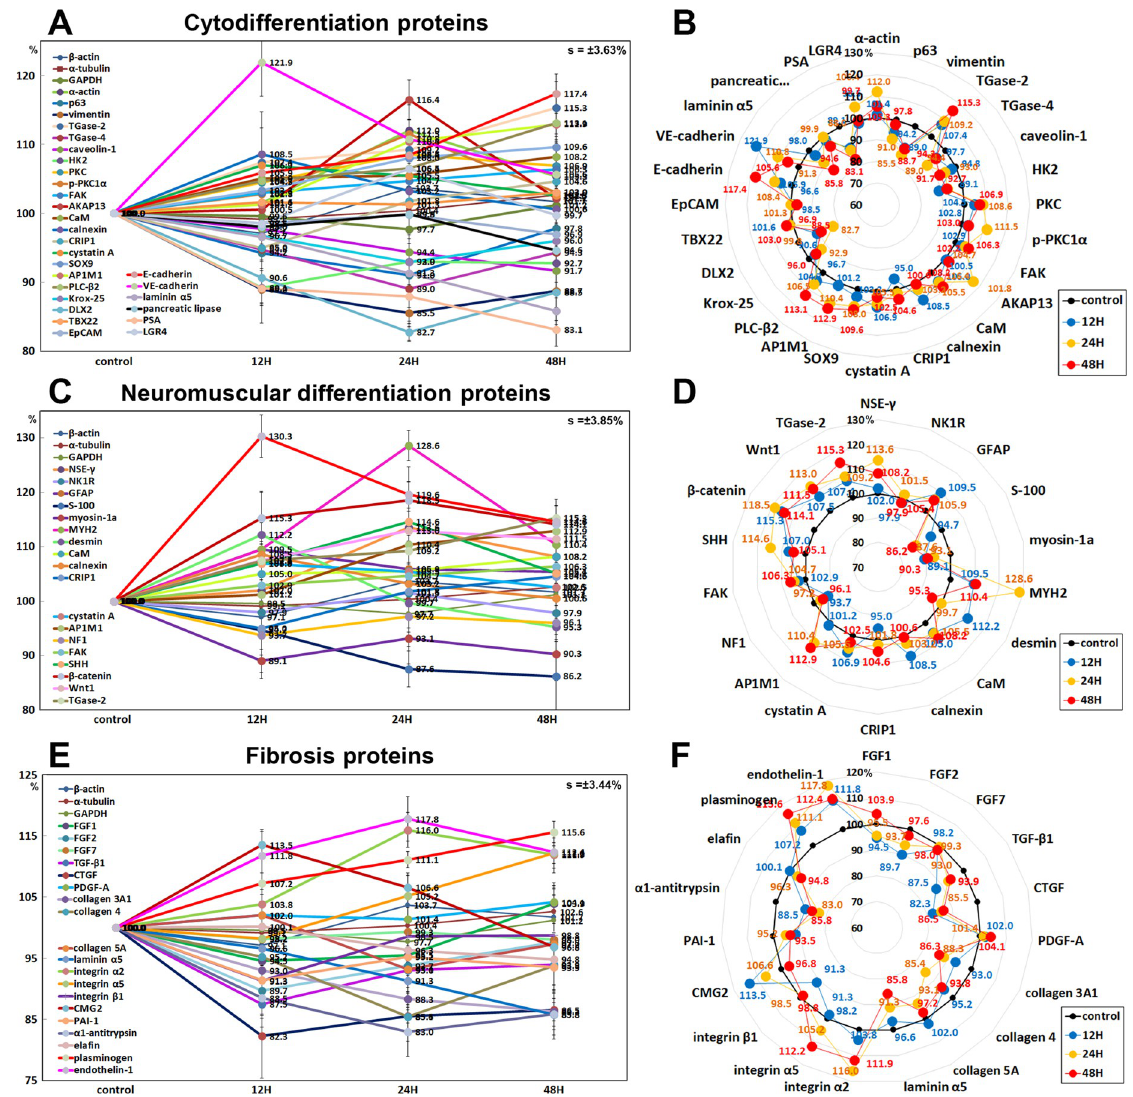
Fig 14. Expression of cytodifferentiation proteins (A and B), neuromuscular differentiation proteins (C and D), and fibrosis proteins (E and F) in 10 μ g/mL PTX-treated RAW 264.7 cells as determined by IP-HPLC. Line graphs, A, C, and E show protein expression on the same scale (%) versus culture time (12, 24, or 48 h), whereas the star plots (B, D, and F) show the differential expression levels of the proteins at 12, 24, or 48 h after PTX treatment on the appropriate scales (%). The thick black line, untreated controls (100%); the blue, yellow, and red dots show differential protein levels after PTX administration for 12, 24, or 48 h,